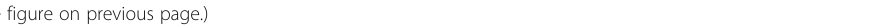
Table 4 Effect of the red wine phenolic extract (Provinols TM ), rich in anthocyanins, and the oenological extract from grape seeds (Vitaflavan ® ) on the live/dead cell ratio (i.e. the area occupied by living cells divided by the area occupied by dead cells) of the Exposure time